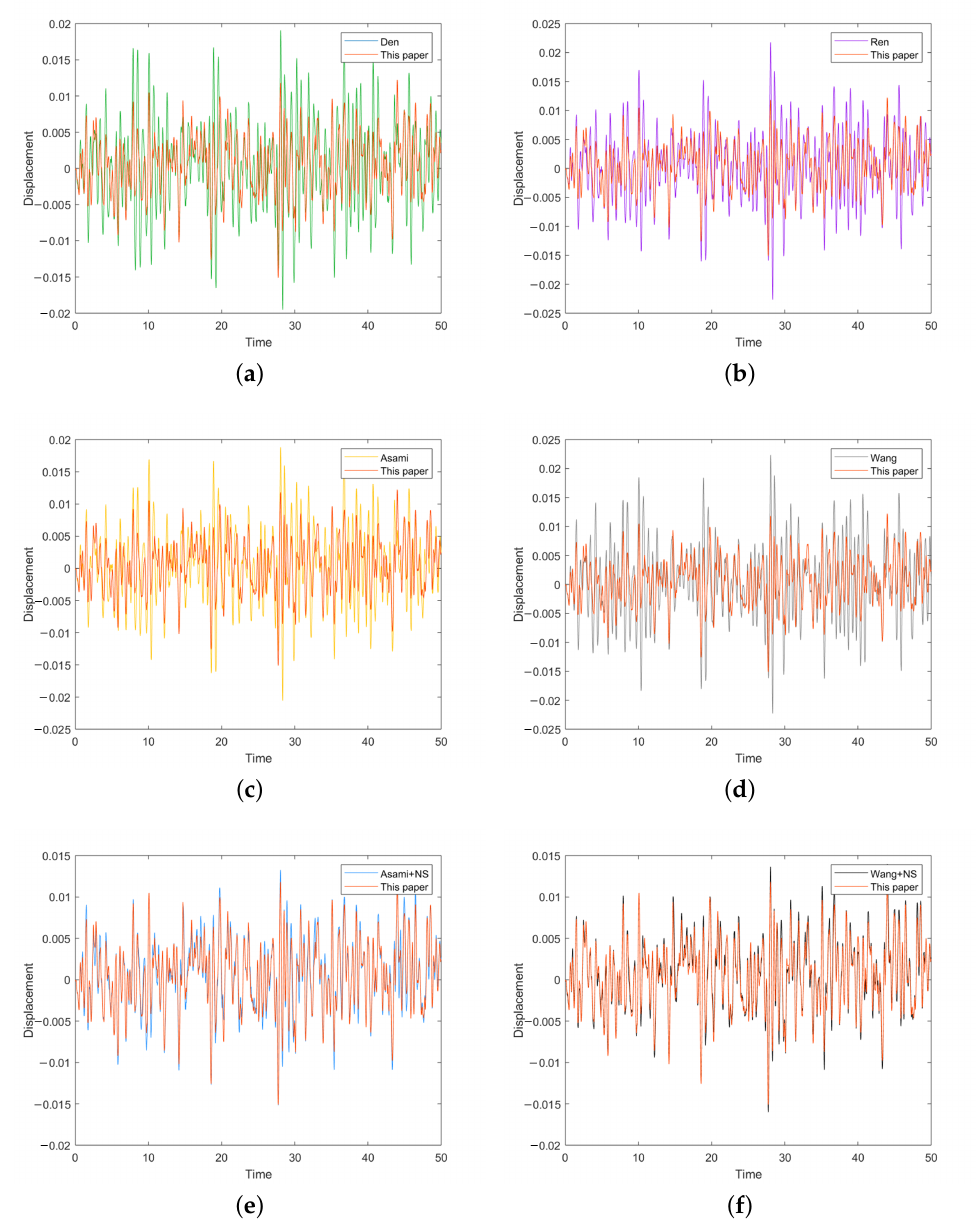
Figure 16. The time history of the primary system with models when µ = 0.1: ( a ) Den; ( b ) Ren; ( c ) Asami; ( d ) Wang; ( e ) Asami with negative stiffness; ( f ) Wang with negative